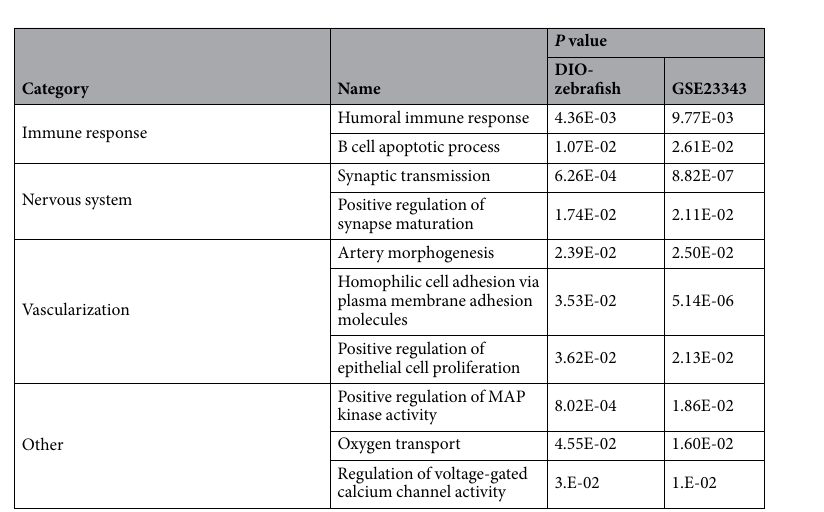
Table 3. Gene-sets common to the hepatopancreas of DIO zebrafish and hyperglycaemic liver of human type 2 diabetes mellitus patients (GSE23343) according to Gene-Set Enrichment Analysis (GSEA)